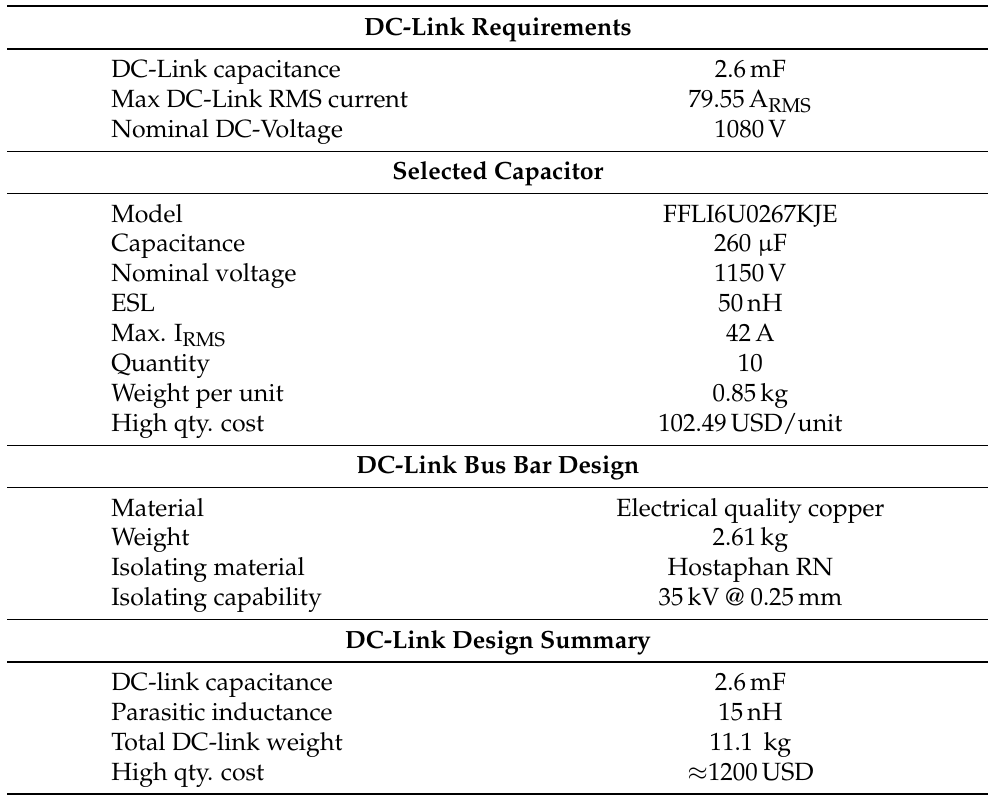
Table 5. DC-Link design